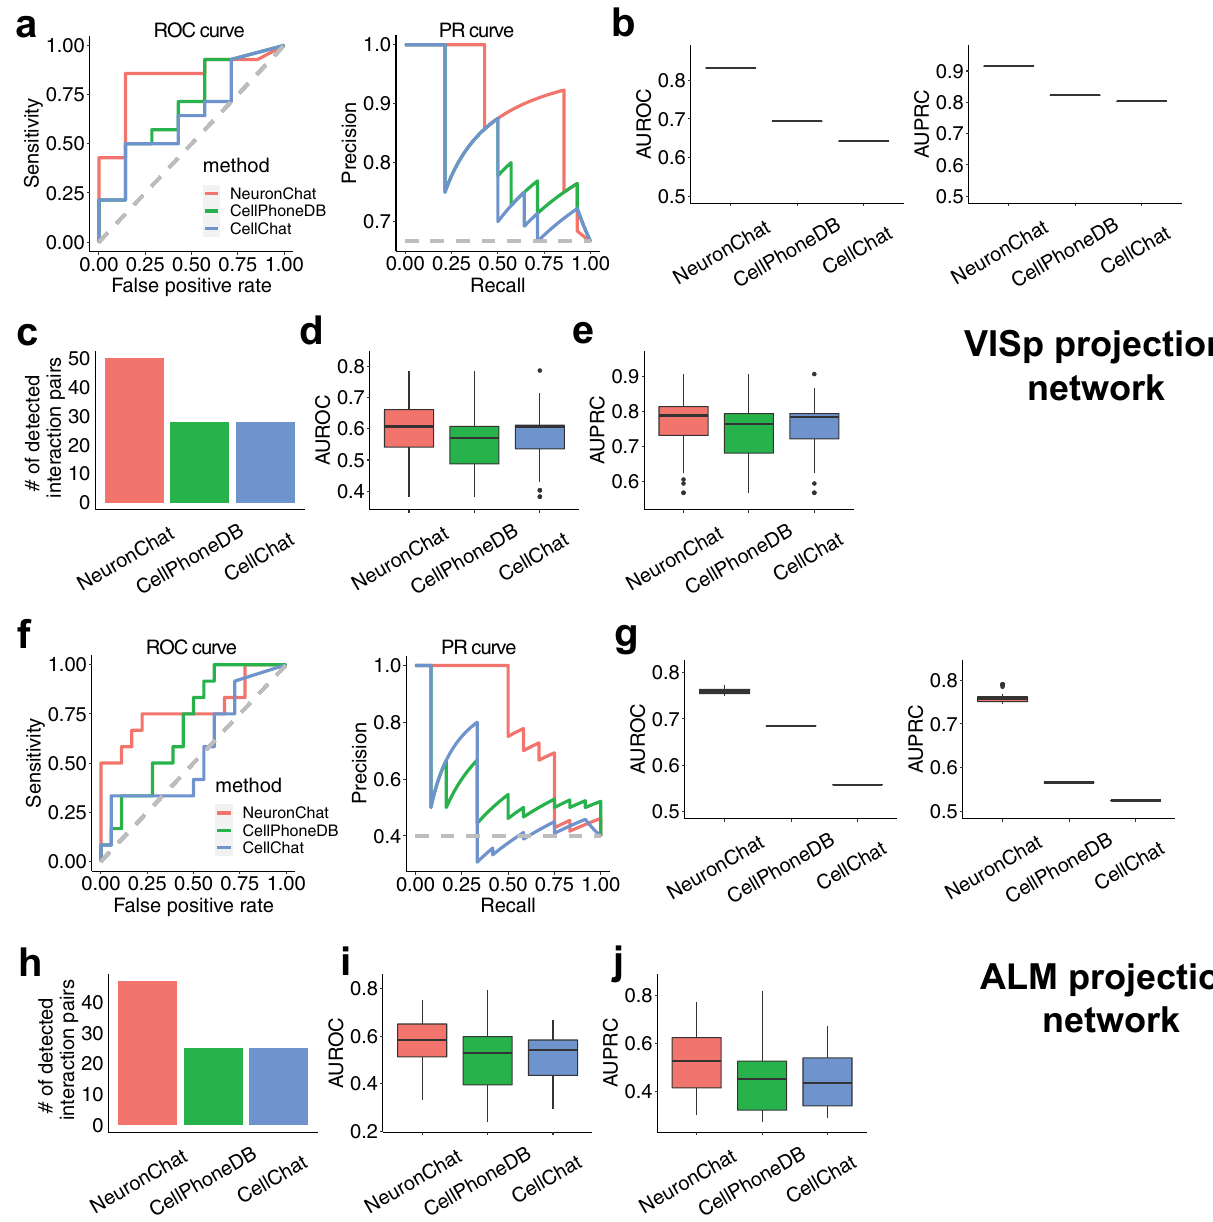
Fig. 3 | Comparison of NeuronChat, CellPhoneDB, and CellChat in predicting VISp and ALM projection networks. a Typical ROC curves (left panel) and PR curves for the three methods. b The boxplots of AUROC (left panel) and AUPRC (right panel) values for 100 repeats of the aggregated VISp projection networks inferredbythethreemethods.Eachboxplotrepresents100independentrepeated computations. Boxplot elements: center line, median; box limits, upper and lower quartiles; whiskers, 1.5x interquartile range; points, outliers. Note that no variation in each boxplotisobserved becausethe aggregated method “ thresholded_weight ” reduces the fl uctuation caused by fi nite sampling in the permutation test (see also